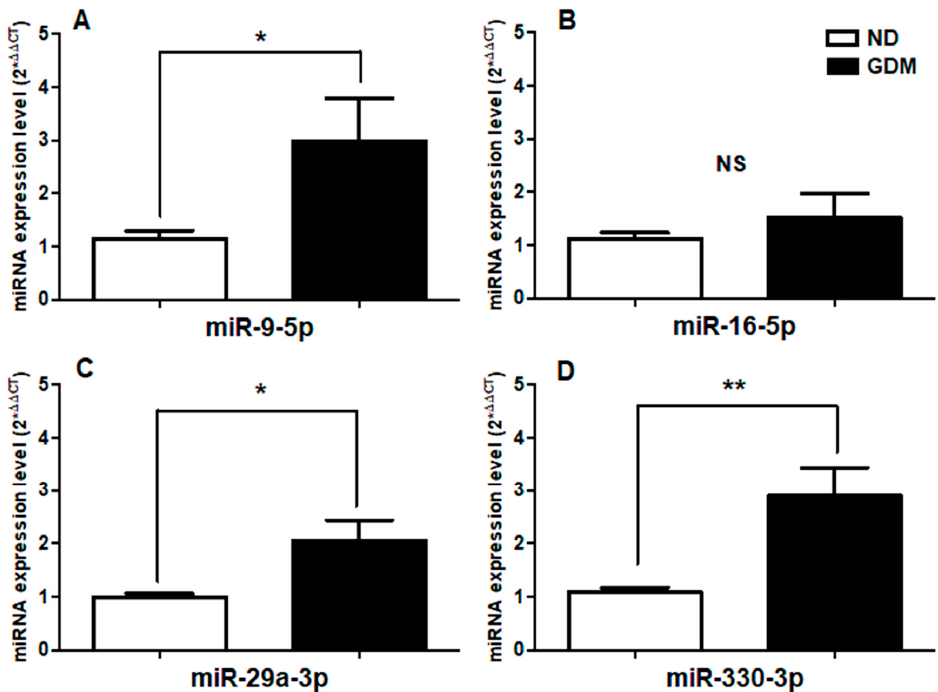
Figure 2. Changes in the relative expression of circulating miRNAs in pregnant women with GDM. mir-454 was used as endogenous control. ND, Non-diabetic patients. GDM, Patients with gestational diabetes mellitus. ( A ) miR-9-5p, ( B ) miR-16-5p. ( C ) miR-29a-3p. ( D ) miR-330-3p. The data shown correspond to the mean values + standard error mean. The statistical significance was determined by Mann-Whitney U -Test. * p < 0.05, ** p < 0.01, NS. not significant.